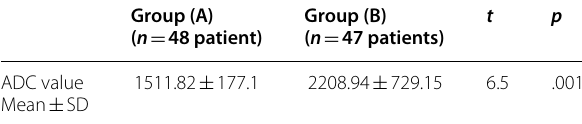
Table 6 ADC value between the two groups